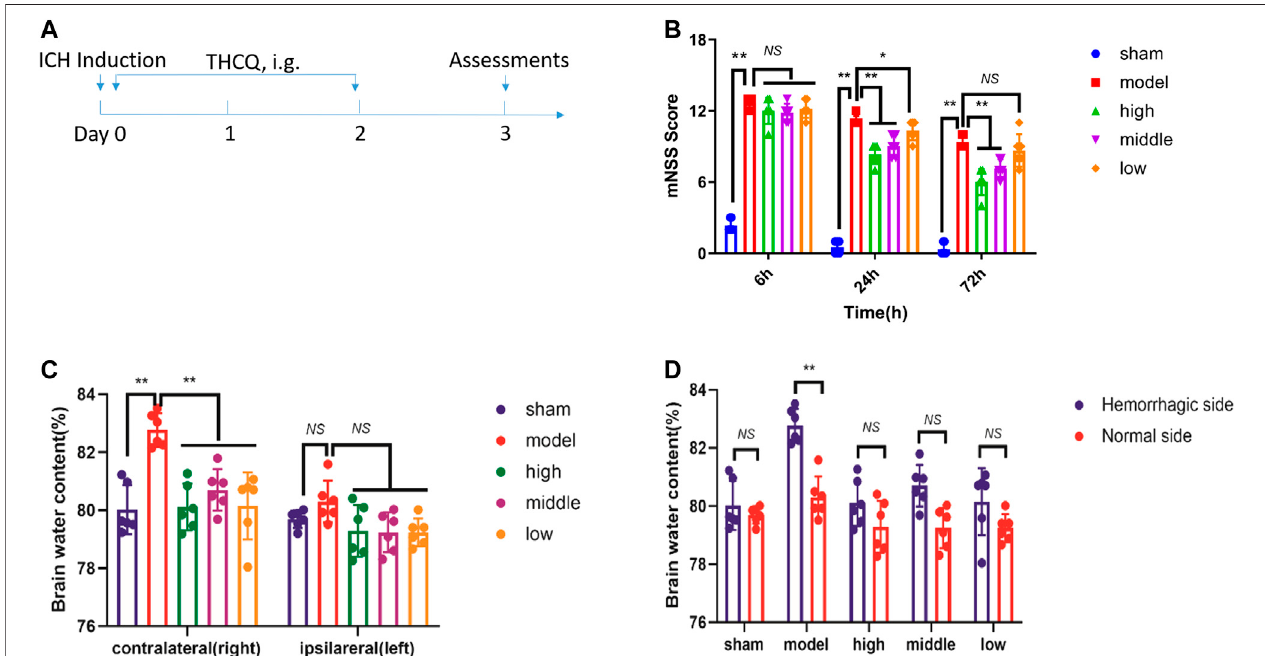
FIGURE 1 | THCQ attenuates brain injury and improves long-term outcomes after ICH. ICH was induced in SD rats by injection of collagenase. Flow chart illustratingTHCQadministrationandtheexperimentaldesign.Ratsreceiveddailyintraperitoneal(IG)injectionsofTHCQ(28.2,56.4and112.7 mg/kg)oranequalvolume ofphosphate-buffered saline (PBS) vehiclefor3 consecutive days starting immediately after ICH induction (A) . Neurological tests wereperformed toevaluate the motor, sensory,andbalancefunctionsinmicereceivingvehicleorTHCQat6 h,24 h,and72 hafterinjectionofcollagenase(right) (B) .Similarly,THCQtreatmentatdoses of 28.2, 56.4 and 112.7 mg/kg markedly alleviated the histological changes evaluated via the BWC (C, D) (n (cid:2) 6 rats/group) measured by the dry/wet weight method at 72 h after ICH. n (cid:2) 6 per group. Data are presented as the mean ± SD. * p < 0.05, ** p < 0.01.